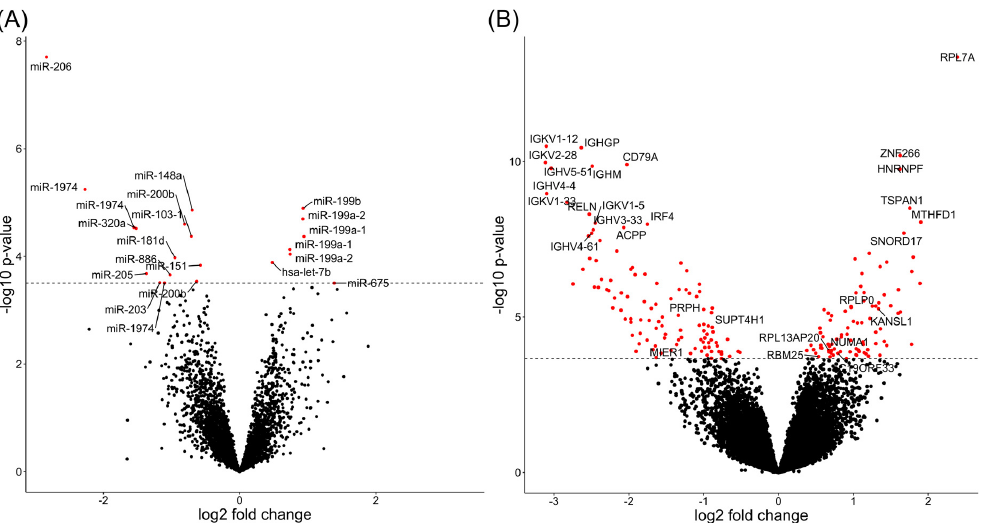
Figure 2. Differential expression analysis of miRNA and mRNA transcripts. ( A ) Significant differ- entially expressed miRNA isoforms ( n = 21) are shown in red. The Benjamini–Hochberg adjusted significance threshold is indicated by the dashed line. Transcripts with a positive fold change are upregulated in resistant patients, whereas transcripts with a negative fold change are downregu- lated in resistant patients. ( B ) Significant differentially expressed mRNA transcripts ( n = 196) are shown in red. The Benjamini–Hochberg adjusted significance threshold is indicated by the dashed line. Transcripts with a positive fold change are upregulated in resistant patients, whereas tran- scripts with a negative fold change are downregulated in resistant patients. Gene symbol labels are provided for the top 20 most significant mRNAs, as well as for mRNAs that were replicated in an independent cohort (Results Section 2.7, Table S11). Differential expression analysis identified 196 mRNAs associated with chemother- apy response (adjusted p < 0.05) that map to 190 unique genes (Figure 2B, Table S3). Path- way enrichment analysis of these associated transcripts indicated enrichment of 41 anno- tation terms, including B-cell receptor regulation, complement activation, and peptide chain elongation (Table S2). 2.3. miRNA Coexpression Networks Involved in Lipid Transport and Oncogenic Pathways Associated with Chemotherapy Response Weighted gene coexpression network analysis (WGCNA) of the miRNA dataset con- structed 100 coexpression modules (Table S4), of which three are associated with chemo- therapy response. The ivory ( p = 0.0098, log OR = − 5.67) and lightcoral ( p = 0.042, log OR = − 4.36) modules are negatively associated with chemotherapy resistance, while the third plum network ( p = 0.045, log OR = 4.29) is positively associated with chemotherapy re- sistance. The ivory network consisted of 25 miRNA isoforms mapping to 11 unique miR- NAs (Figure 3A, Table S5), which are enriched for seven pathways and functions, includ- ing regulation of lipoprotein transport and cholesterol efflux (Table S2). The lightcoral module consists of 17 isoforms of miR-187 and the plum network consists of 17 isoforms of miR-221 and miR-222 (Figure 3A, Table S5). While no pathway annotations were de- rived for the lighcoral module, the plum module is enriched for 18 pathways and oncogenic functions, such as inhibition of the TRAIL-activated apoptotic pathway and inflammatory cytokine production, and upregulation of protein kinase B signaling (Table S2).